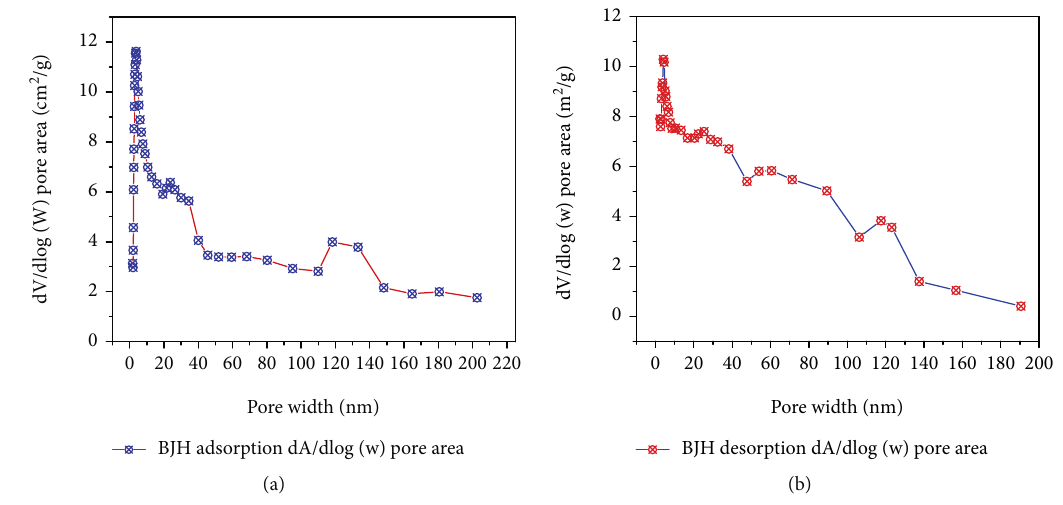
Figure 4: (a) BJH adsorption dV/dlog (W) pore area of M-ARM. (b) BJH desorption dV/dlog (W) pore area of